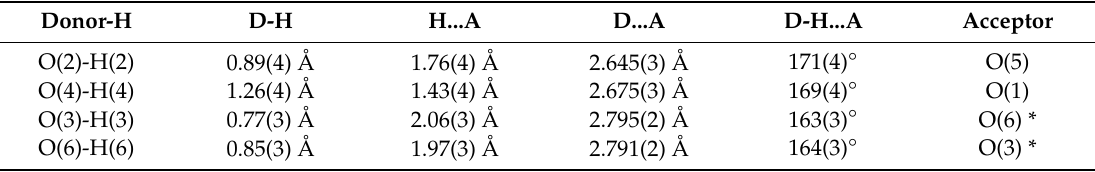
Table 2. Geometrical parameters of H-bonds. Atom numbering refers to Figure 6a, atoms marked with asterisks belong to symmetry-related molecules.